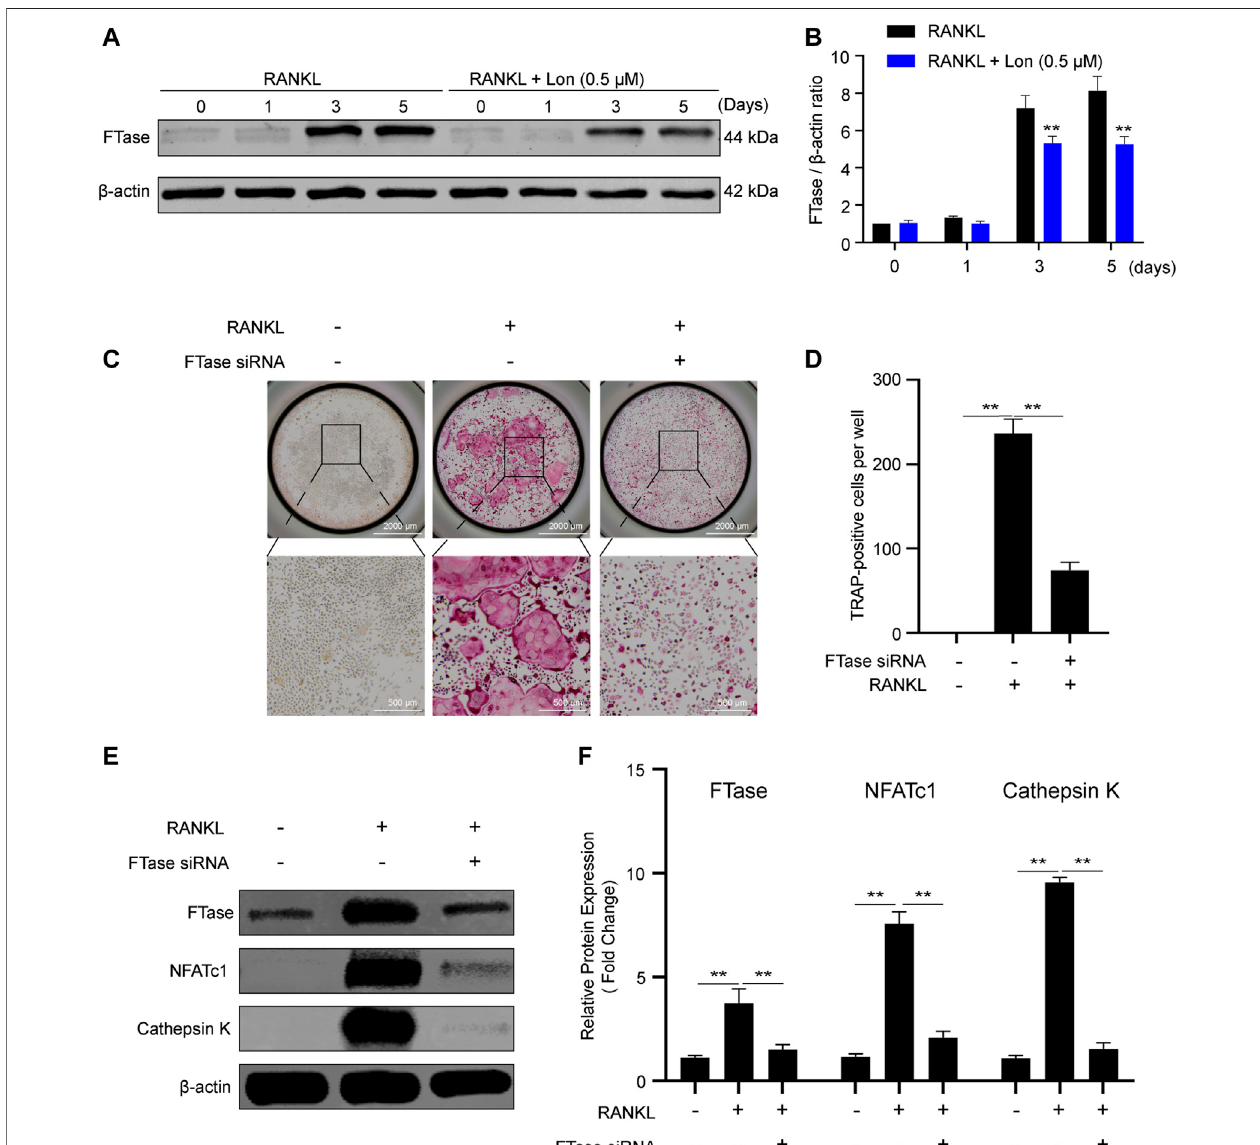
FIGURE 7 | Lon dampens FTase and inhibition of FTase reduces osteoclast activation. (A) FTase expression and the effect of Lon on suppressing FTase was assessed via Western blotting at the indicated time points during osteoclastogenesis. (B) Quanti fi cation analysis of the ratio of FTase to β -actin. (C) Representative images of TRAP staining showing that the effects of RANKL-induced osteoclastogenesis via silence the FTase gene. (D) Quanti fi cation analysis of TRAP-positive cells. (E) Representative Western Blot images of the expression levels of FTase and osteoclast-related proteins including NFATc1 and Cathepsin K through silence the FTasegene. (F) Quanti fi cation ofthe ratios of band intensity ofFTase, NFATc1, and Cathepsin K relative to β -actin ( n = 3 per group). All of the above data are expressed asthemean±SD.* p < 0.05,** p < 0.01relativetoRANKL-inducedcontrolgroup.FTase,farnesyltransferase;Lon,Lonafarnib;NFATc1,nuclearfactorofactivatedTcells 1; RANKL, receptor activator of nuclear factor- κ B